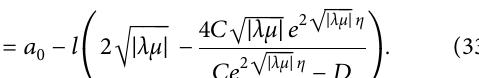
Figure 4: Exponential function solution (29) for equation (1) with l � 2 , m � 1 , λ � − 1 , μ � 2 , a spective viewof thereal part ofthe wave.(b)The overhead viewof thewave. (c)The wave propagationpatternof the wavealong the x axiswith y �